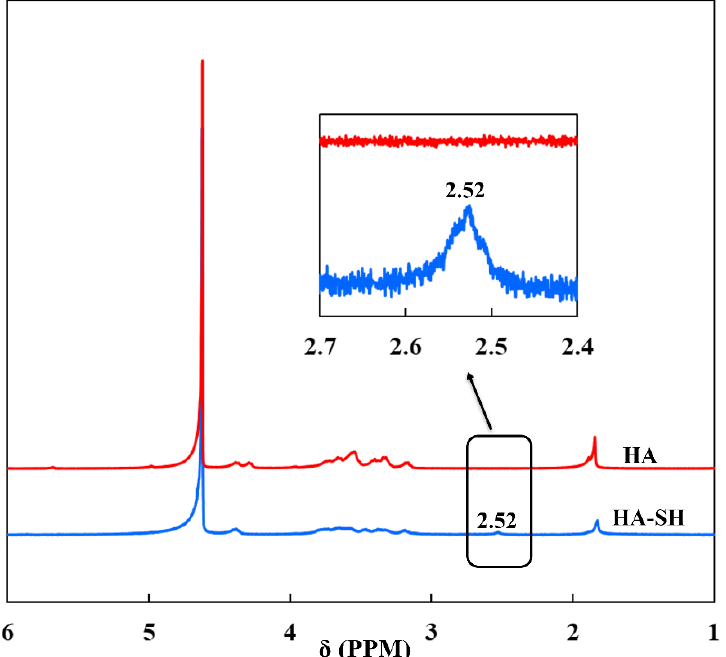
Figure 1. Proton nuclear magnetic resonance ( 1 H-NMR) of hyaluronic acid (HA) and thiolated hyaluronic acid (HA-SH), in which δ = 2.52 PPM belongs to the methylene protons of the cysteamine moieties.